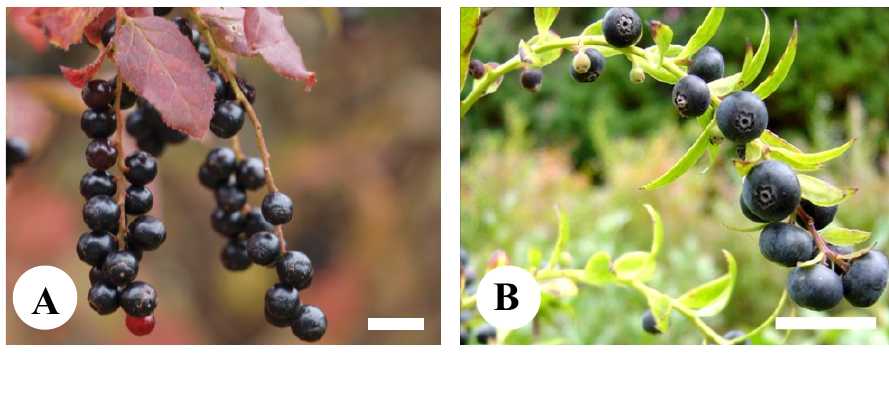
Figure 1. The fruits of Natsuhaze ( V. oldhamii Miq.) ( A ) and Shashanbo ( V. bracteatum Thunb.) ( B ). Bars indicate 10